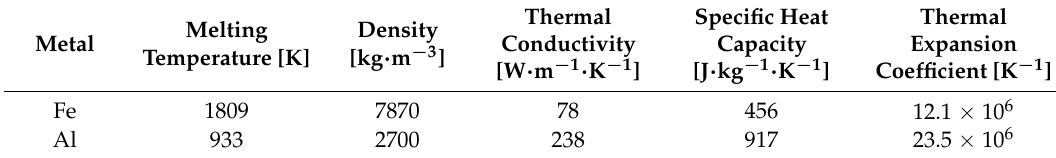
Table 1. Properties of the Fe and Al at room temperature [22].